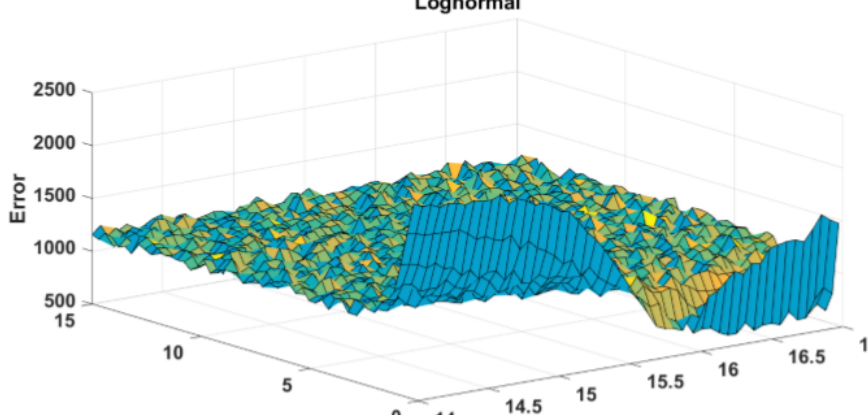
Figure 7. Fuel combustion in a steam generator and the results of the study. We present experimental data on the operation of BKZ boilers (Boiler unit type BKZ). For the boiler, the data are given at the rated load of the boiler D = 53 kg of steam per second, in addition, when burning coal with a calorific value of 24.560 kJ/kg. Param ‐ eters measured in the experiment: speed w 0 = 8 m/s, Т 0 = 1371 К , d 0 = 0.9 m, Т = 1721 К , l = 5.33 m. For a boiler with a nominal boiler load of D = 44 kg of steam per second, in addi ‐ tion, when burning coal with a calorific value of 22.450 kJ/kg, the parameters measured in the experiment are: speed w 0 = 9.2 m/s, Т 0 = 1389 К , d 0 = 0.86 m, Т = 1685 К , l = 4.75 m. The obtained experimental data show the dependence of temperature and speed on the type of fuel and the operating mode of the boiler.